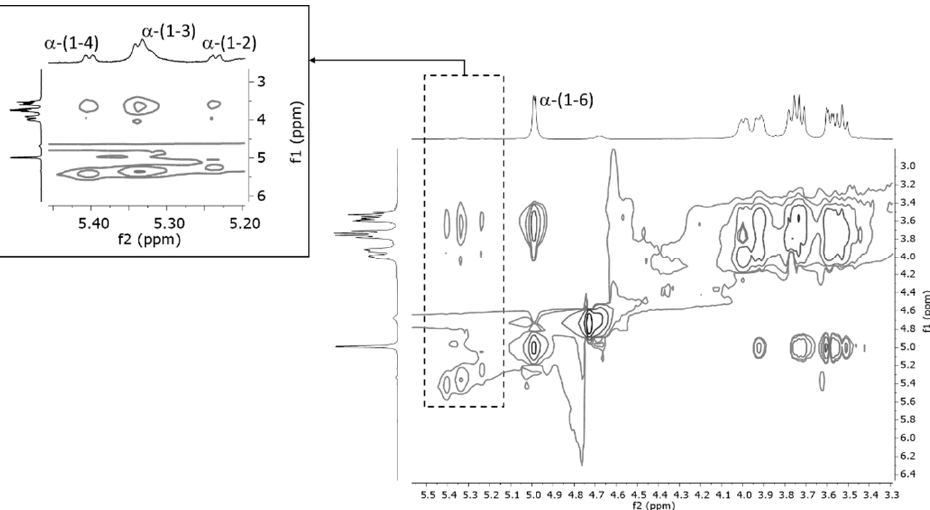
Figure 2. The TOCSY spectrum of EPS extracted from C43–11 + S recorded at 400 MHz in D 2 O at 303 K. Anomeric protons are labeled as α -(1–6), α -(1–2), α -(1–3), and α -(1–4).